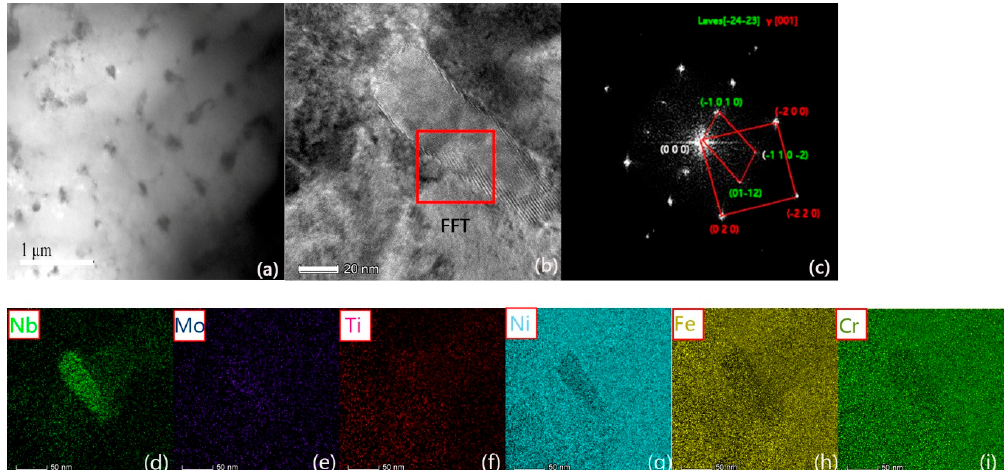
Figure 5. ( a ) The transmission electron microscopy (TEM) image of the XZ section of the sample. ( b ) The high-resolution TEM image of the precipitate. ( c ) The fast Fourier transform (FFT) of the picked region in ( b ). ( d – i ) The element content distribution mapping on this visual field. However, there are also some regular precipitates in the dendrite core area. Figure 6a is the high resolution TEM image of the square precipitate. Figure 6b is the FFT of the red square region in Figure 6a from which the precipitate is indexed to be a face-centered structure, and the FFT pattern is along [011] zone axis. The element content mapping shows that this precipitate is enrichment of Nb, Ti, C, N, and no Ni, Cr, Fe are included in it. Further, according to Reference [23], this regular phase is the carbonitride with the chemical formulae of (Ni, Ti) (C,N), usually in the form of MX. For directionally solidified superalloys, it has been reported that block carbides nucleate on stable TiN during the re-melting process [24].